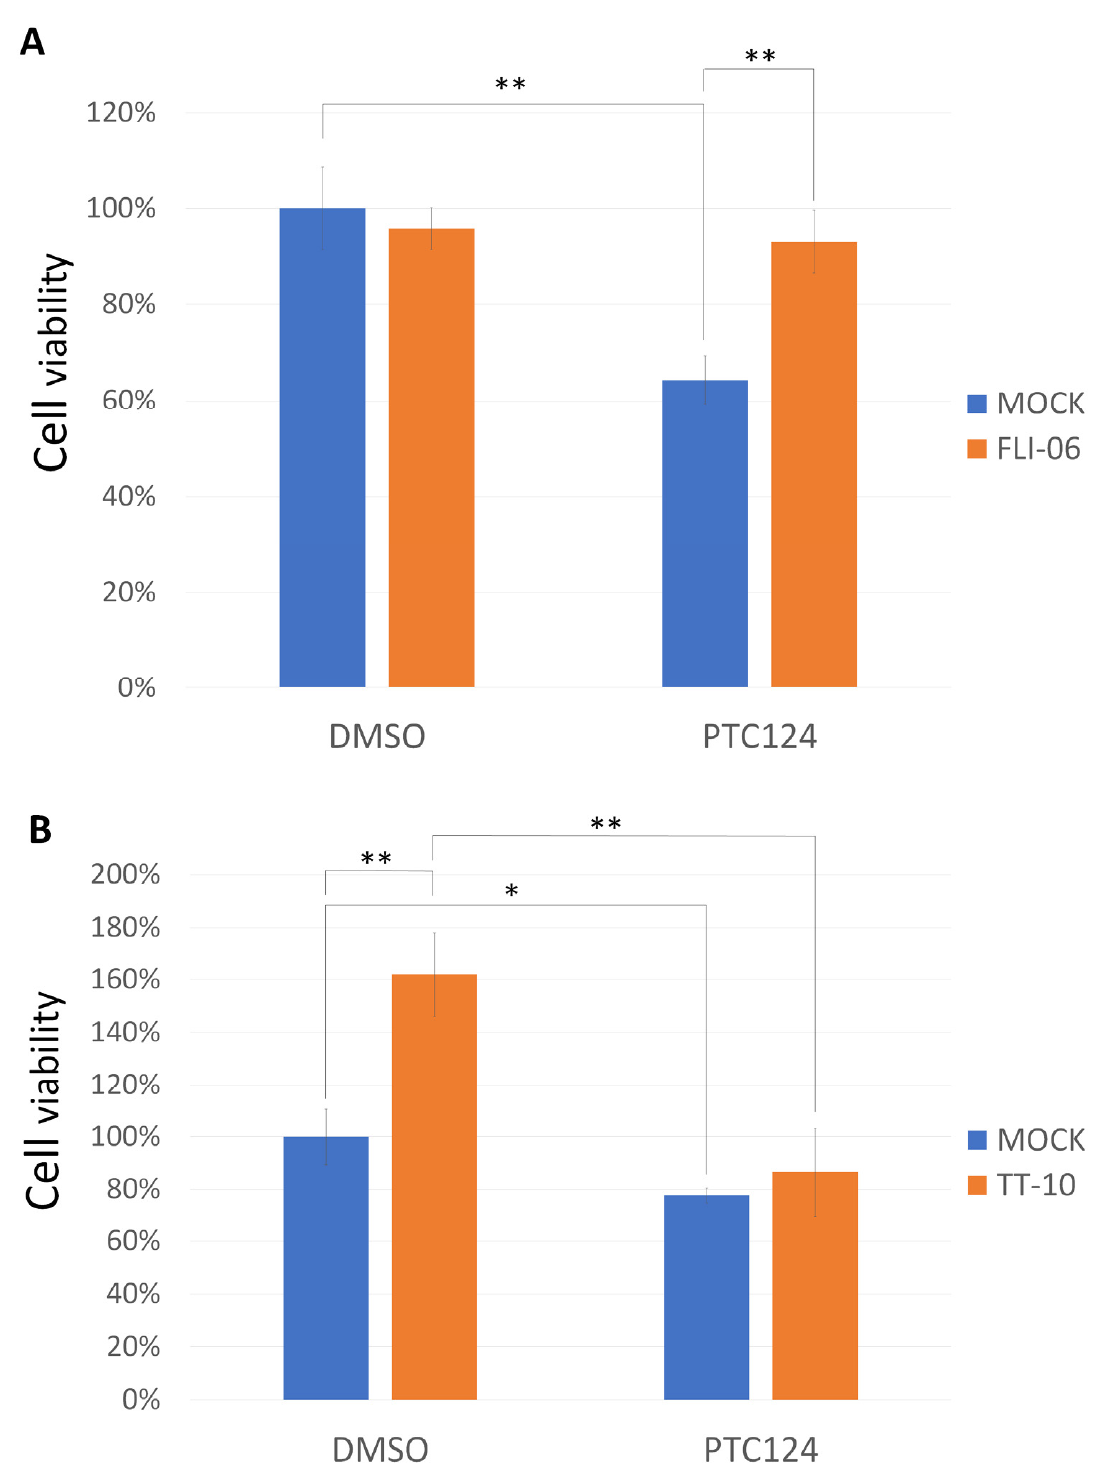
Figure 5. PTC124 can control HNSCC cell growth in DOK and HO-1-u-1 cells. ( A ) FLI-06 (10 µM) was able to reverse PTC124-mediated repression of DOK cell growth (** p < 0.01). DMSO/MOCK was calculated as 1 to normalize for the other conditions. Results are displayed as mean ± SD, n = 3. ( B ) PTC124 could repress HO-1-u-1 cell growth (* p < 0.05). PTC124 could reverse TT-10 (10 µM)-mediated HO-1-u-1 cell proliferation (** p < 0.01). DMSO/MOCK was calculated as 1 to normalize for the other conditions. Results are displayed as mean ± SD, n = 3.